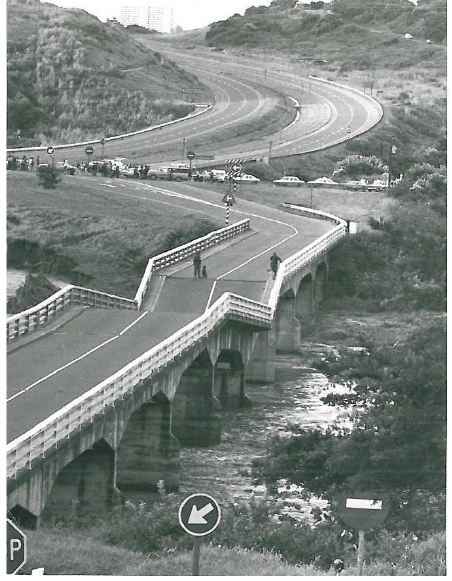
Figure 3. Caissons failure dueto bed erosion (Frankipile, 2008)